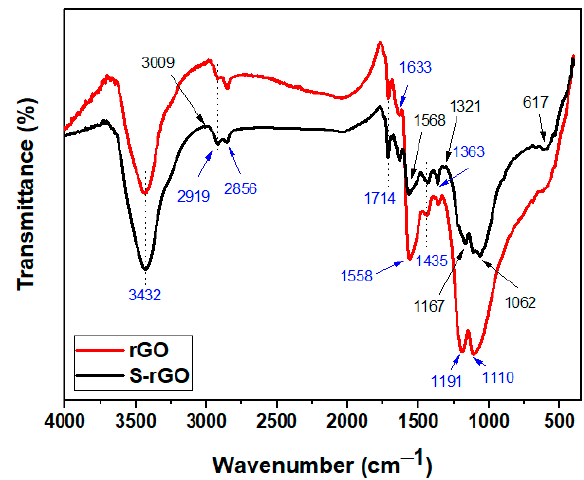
Figure 3. Fourier transform infrared (FTIR) spectra of fumed silica before (A200) and after modification (S-A200).